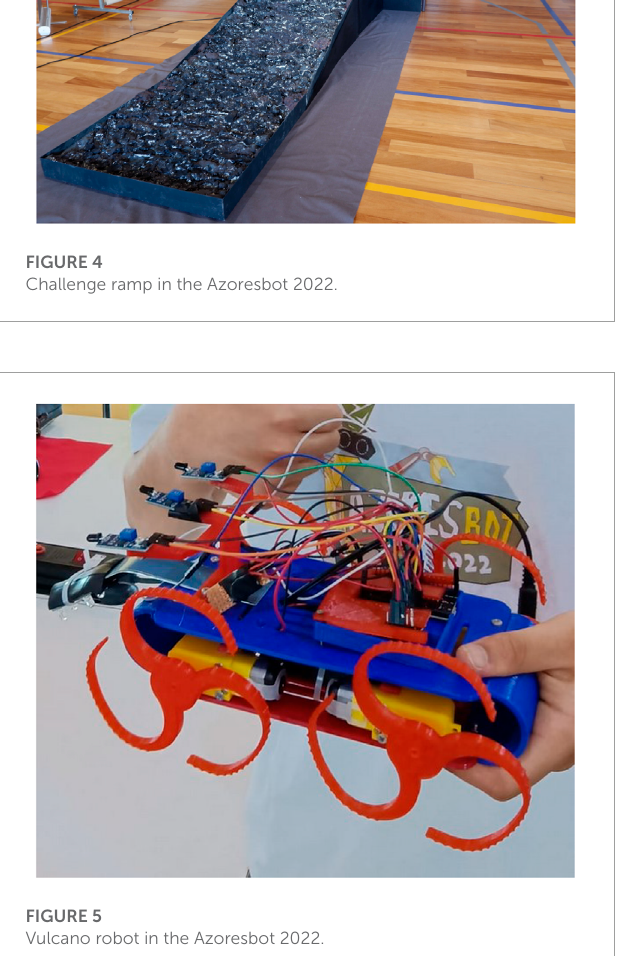
FIGURE 5 Vulcano robot in the Azoresbot